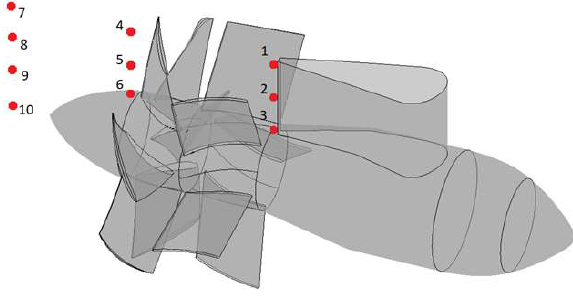
Fig. 2 Points used for evaluation of static pressure